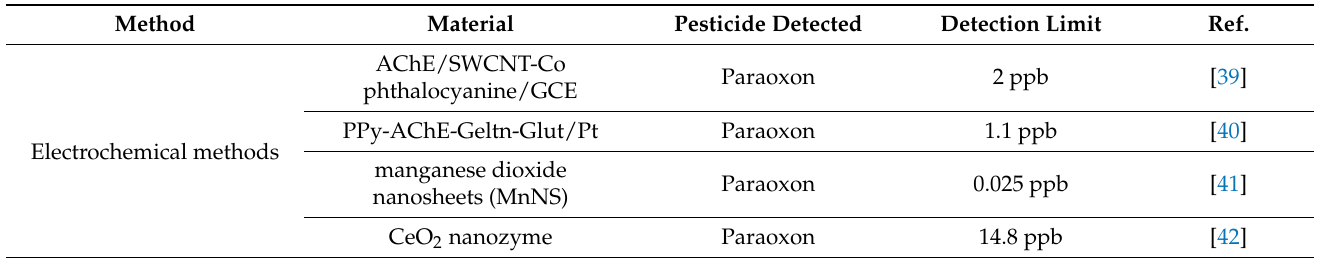
Table 1. Comparison of the performance of biosensors for the detection of